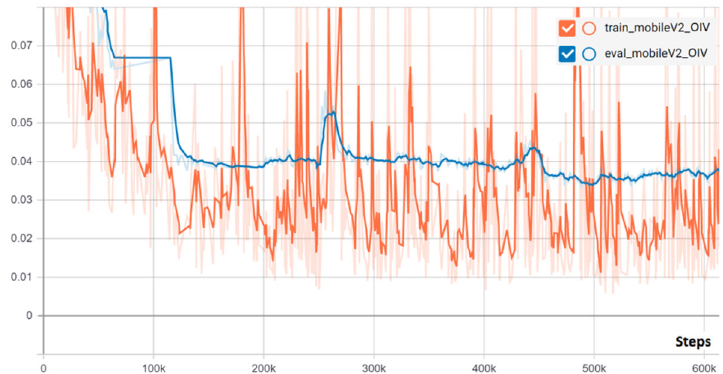
Figure 5. Localization loss training vs. validation MobileNetV2 pre ‐ trained on OID.